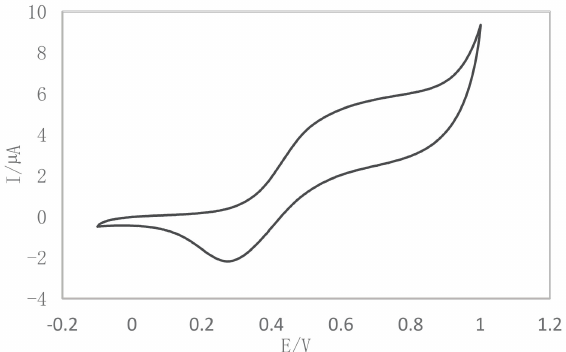
Figure 3. Cyclic voltammetry (CV) of CM extract in pH 7.4 at a scan rate of 30 mV s − 1 .